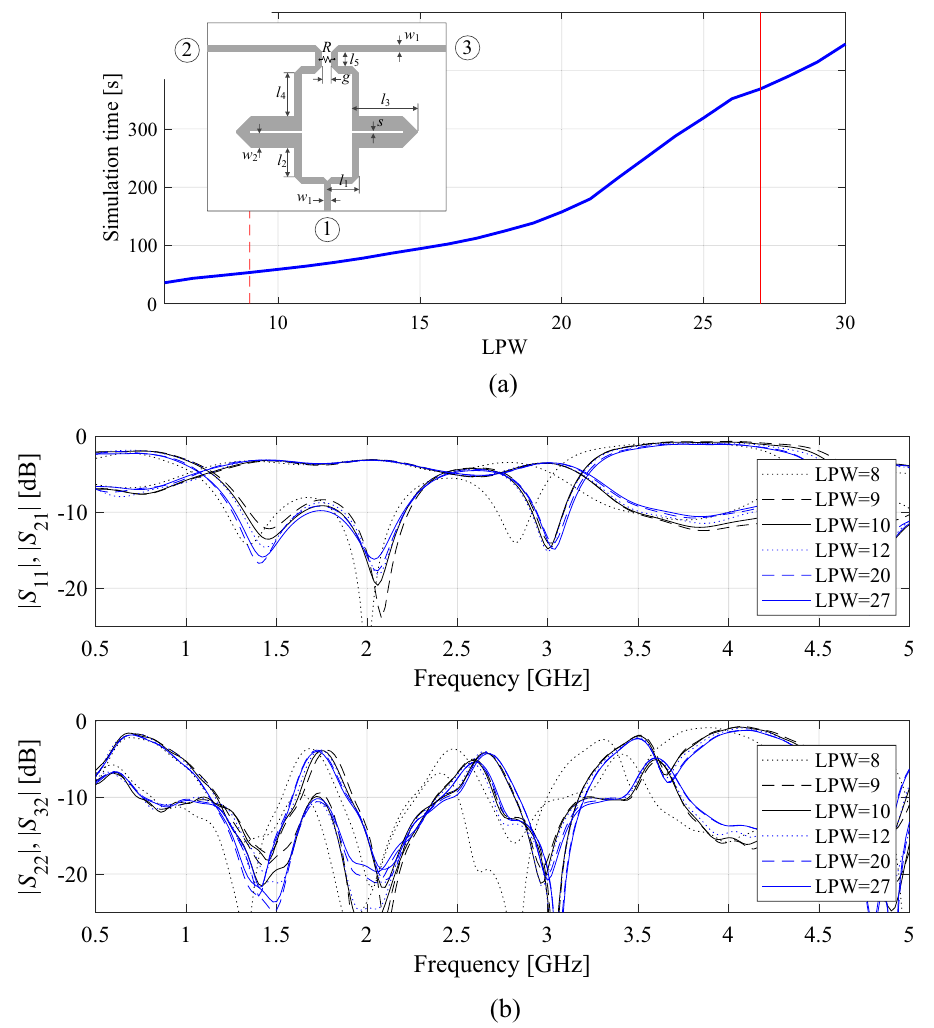
Figure 3. Dual-band power divider with multi-fidelity EM simulations: ( a ) average simulation time vs model resolution (controlled by LPW, i.e., lines-per-wavelength parameter), ( b ) certain S-parameters for the chosen LPW values. The vertical lines denote resolutions of the fine (high-fidelity) model (—), and the coarse (low- fidelity) model